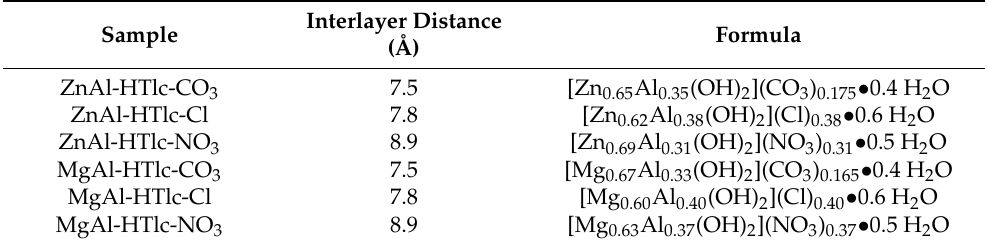
Table 1. Interlayer distance measured by XRPD analysis and empirical formula of